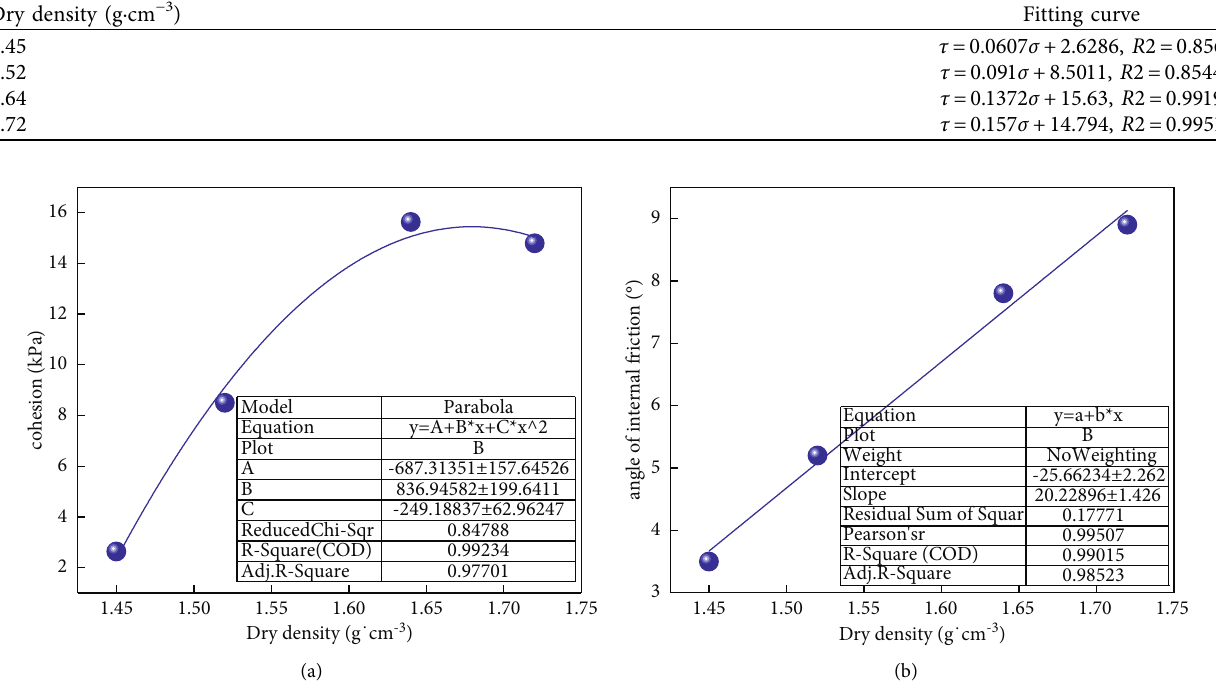
Figure 5: (a) Relationship between dry density and cohesion of silty clay. (b) Relationship between dry density and angle of internal